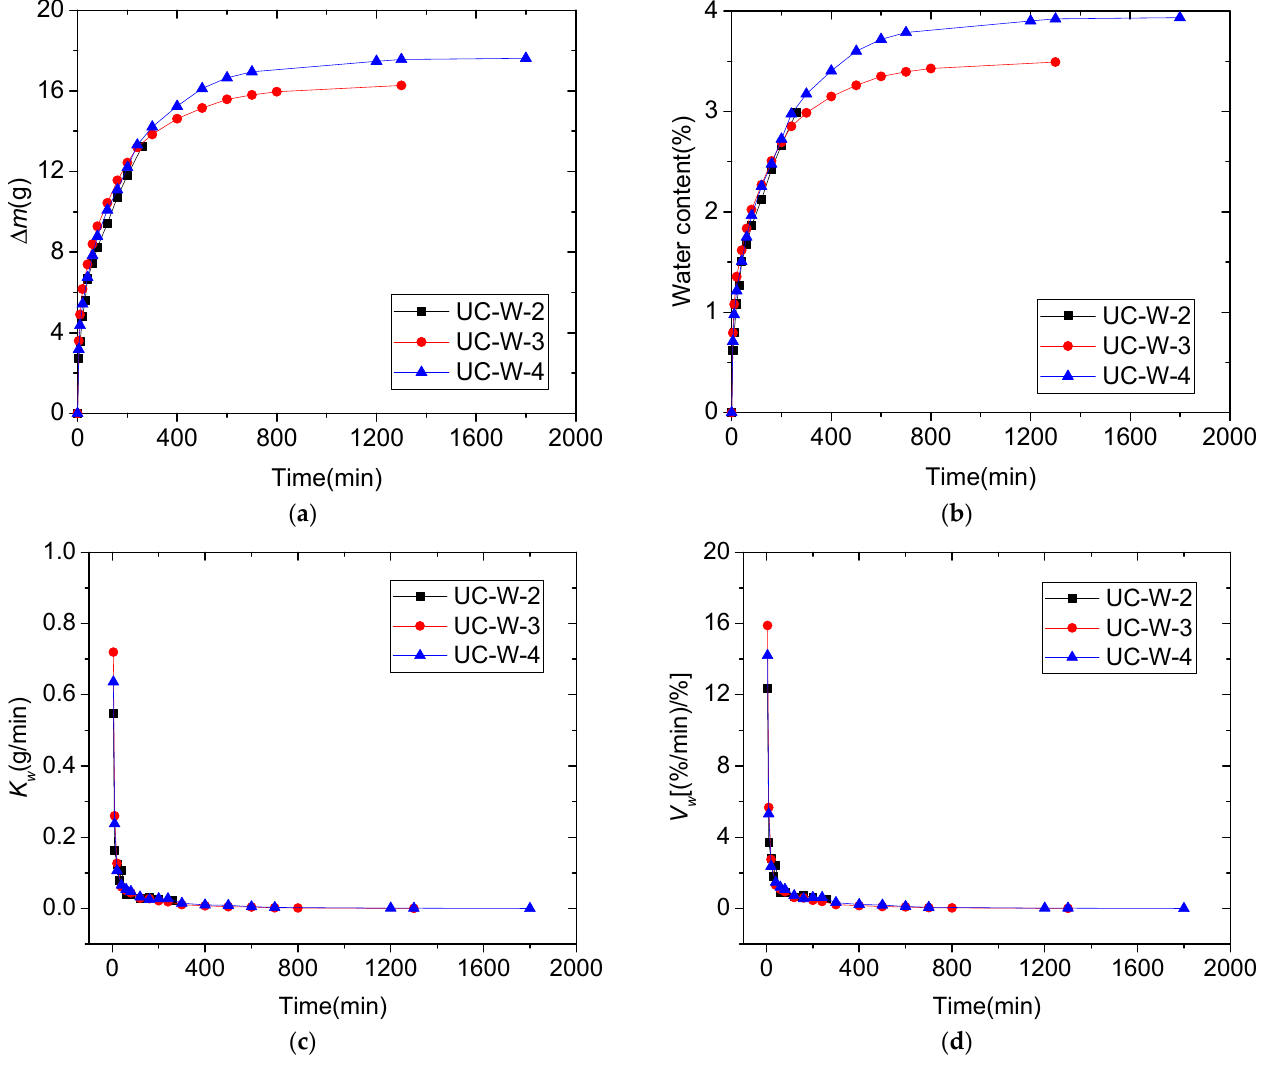
k v Figure 4. Variations of mass difference and water content ( k w and v w , respectively) with immersion Figure 4. Variations of mass difference and water content ( w and w , respectively) with immer- Δ time: ( a ) the relationship between ∆ m and immersion time, ( b ) the relationship between w and sion time: ( a ) the relationship between m and immersion time, ( b ) the relationship between w immersion time, ( c ) the relationship between k w and immersion time, ( d ) the relationship between v w k and immersion time, ( c ) the relationship between w and immersion time, ( d ) the relationship be- and immersion v tween w and immersion time.